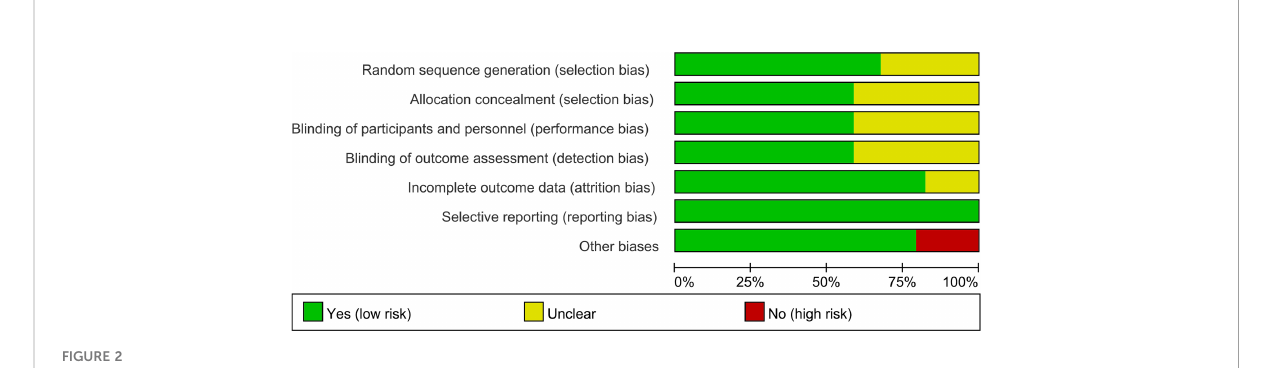
FIGURE 2 Risk of bias graph.